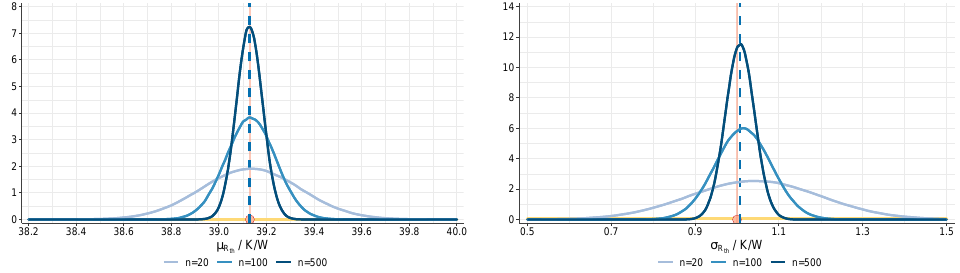
( left ) and σ R ( right ) over th th